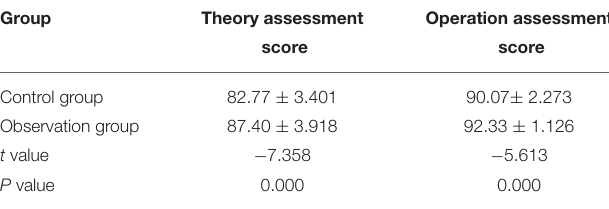
TABLE 2 | Comparison of the assessment results of equipment theory and operation of the nurses between the two groups (points, X ±